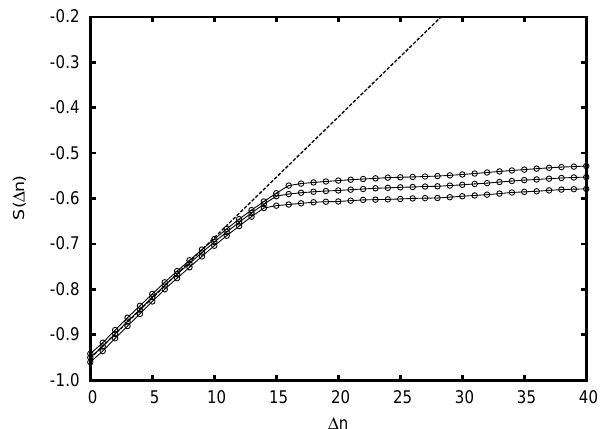
Fig. 11. (a) The local slopes D 2 ((cid:15),m) of original time series for the embedding dimensions m = 1 ,..., 24 with τ = 1 ,ω = 25. (b) The same for the phase randomized time